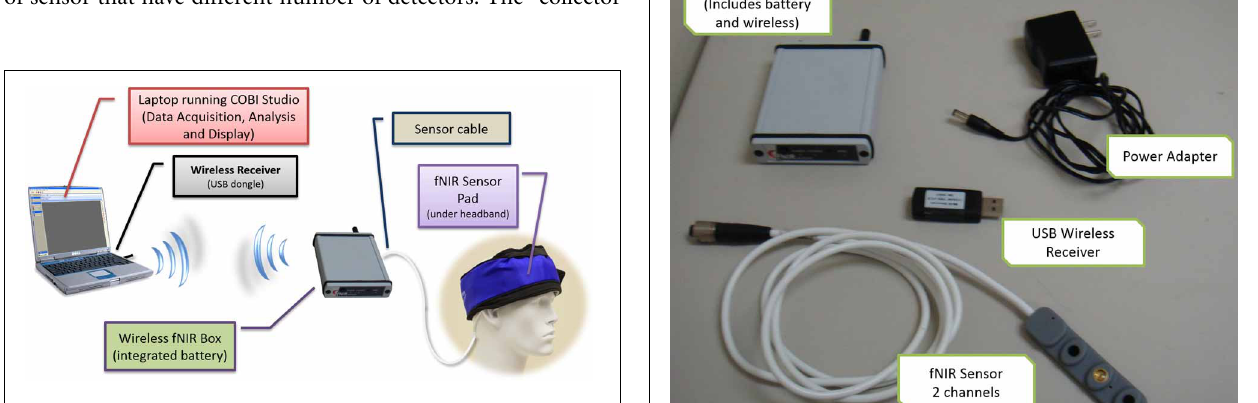
FIGURE 11 | Schematic diagram of the wireless system components. The fNIRS box (approximately the size of a cell-phone) contains, battery, wireless transmitter, and control circuitry. FIGURE 13 | Implemented components of the wireless system.